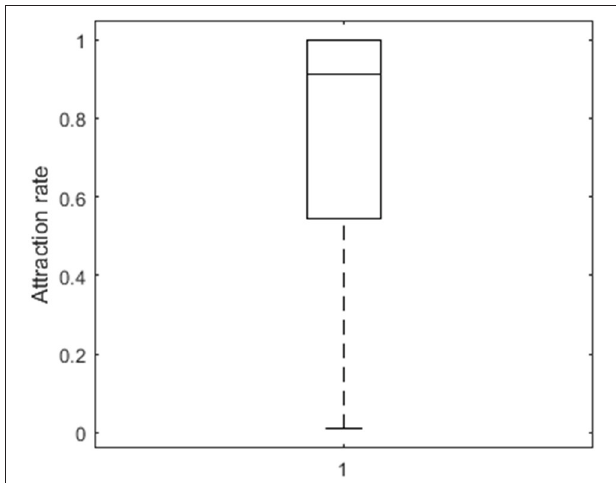
FIGURE 2 | Box plot of the attraction